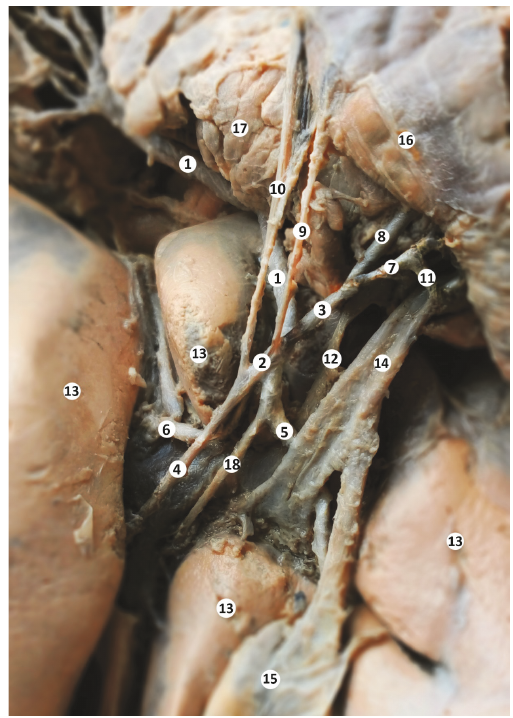
Figure 3: Liver blood supply. Macrospecimen(female, 63-year-old). 1 – common hepatic artery, 2 – proper hepatic artery, 3 – gastroduodenal artery, 4 – left hepatic artery, 5 – right hepatic artery, 6 – accessory left hepatic artery, 7 – right gastroepiploic artery, 8 – superior posterior pancreaticoduodenalartery,9–superiorduodenalartery,10–rightgastricartery,11–thebranchofthesuperioranteriorpancreaticoduodenal artery, 12 – portal vein, 13 – liver, 14 – common bile duct, 15 – gall bladder, 16 – duodenum, 17 – pancreas, 18 – intermediate hepatic